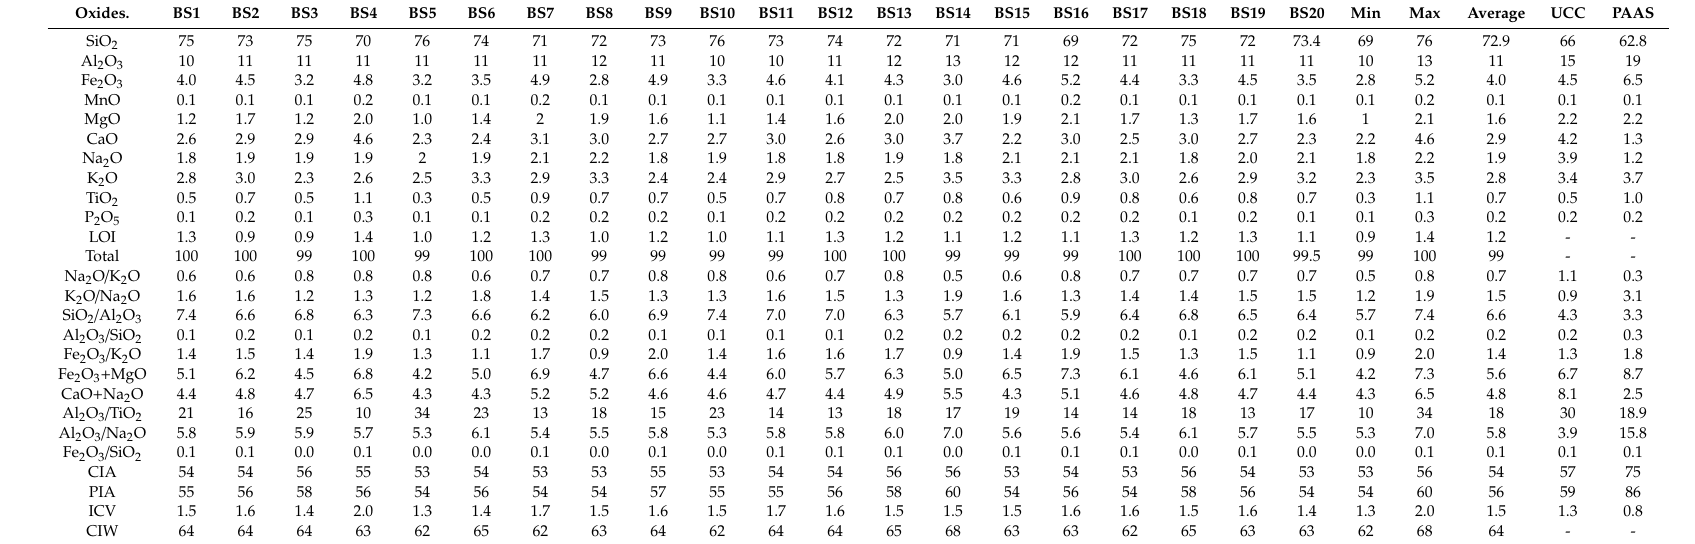
Table 1. Major oxide compositions (wt.%), oxide ratios and weathering indices values of the Brahmaputra River sediments. All data have been hydroxide normalized.